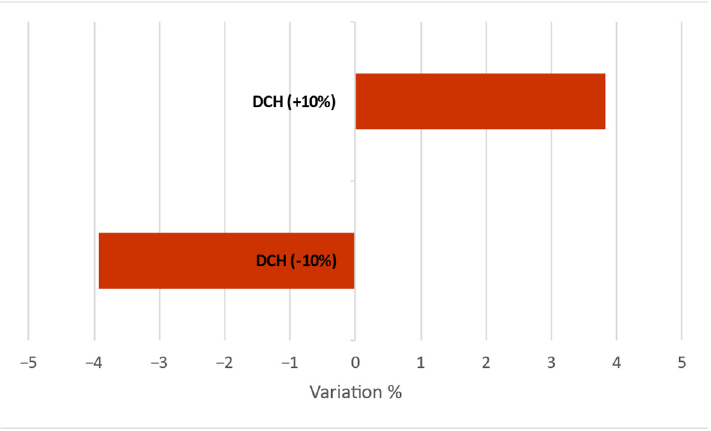
Figure 12. PCT vs. DCH—variation